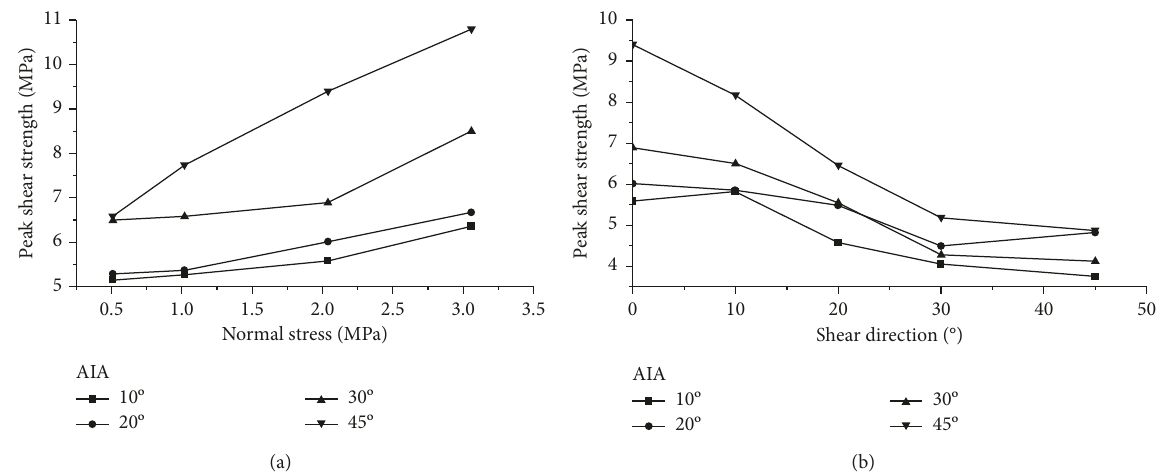
Figure 12: Relationship between shear directions as well as normal stresses and peak shear strengths. (a) Different normal stresses (SD (b) different shear directions (NS